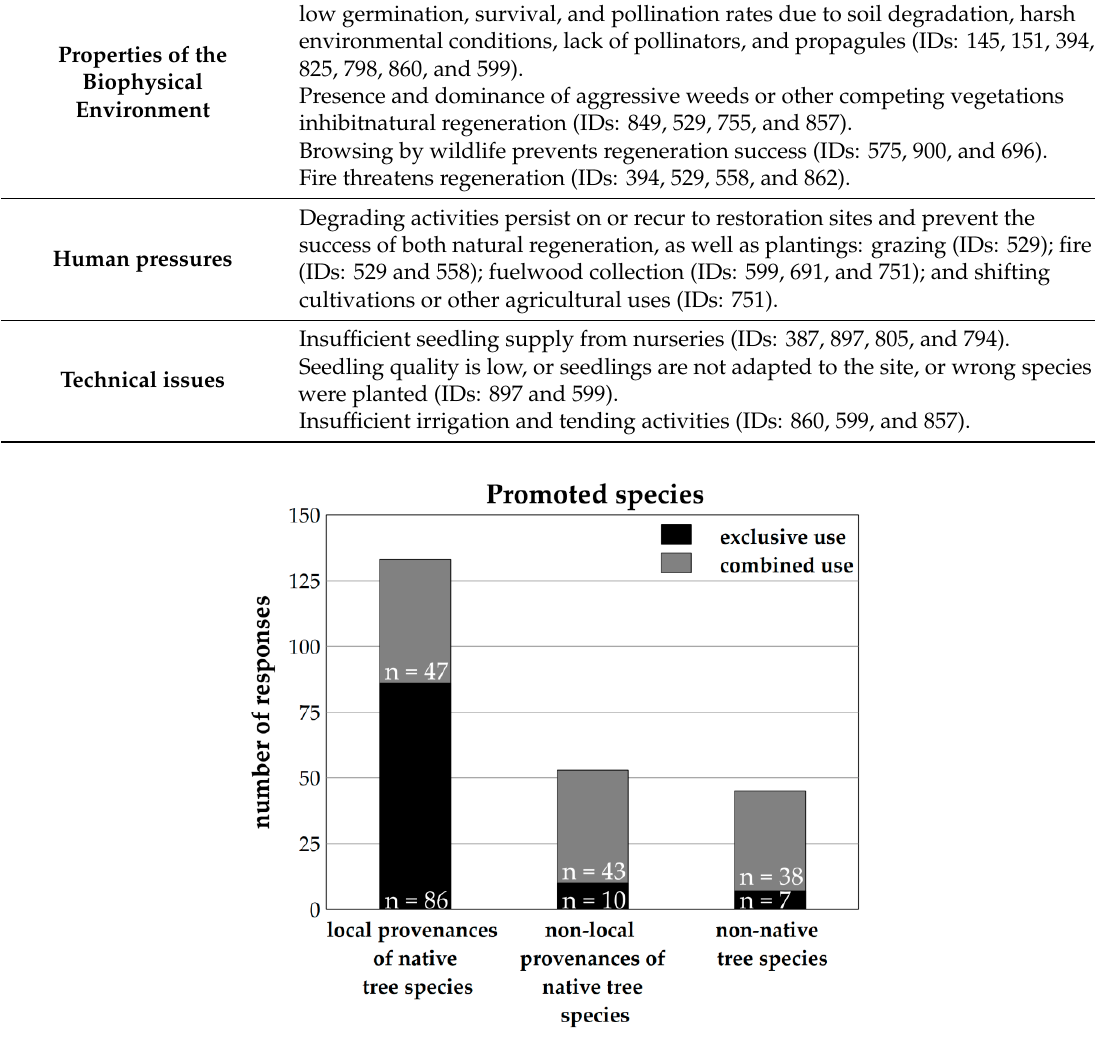
Figure 6. Species promoted in the respective projects—black bars: the respondents reported the exclusive use of the particular type of species, and grey bars: the respondents reported using the particular species type in combination with other species types.